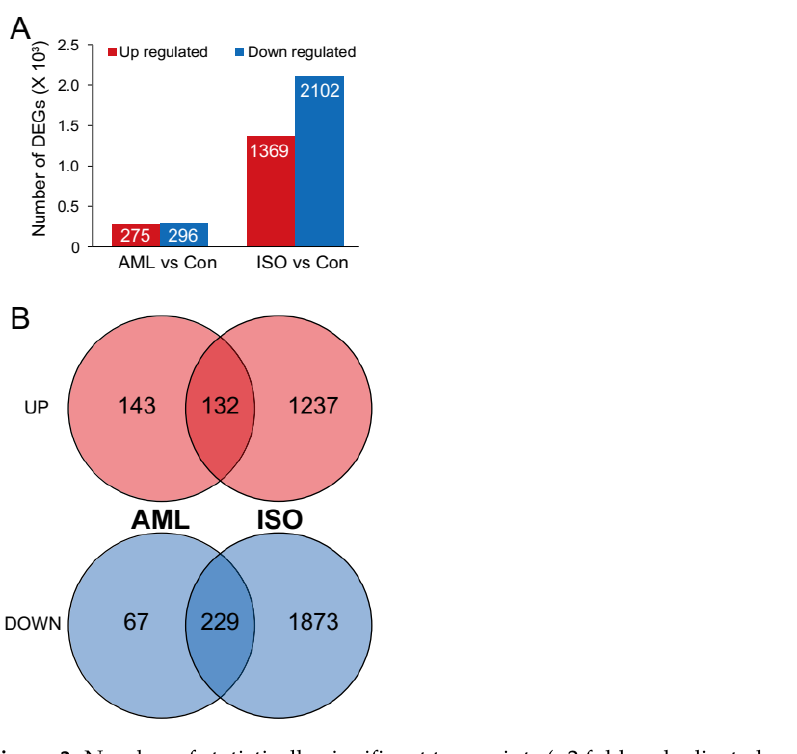
Figure 3. Number of statistically significant transcripts (>2 fold and adjusted- p < 0.05) of genes in AML and ISO exposure groups ( A ) and the number of uniquely or commonly up- or down-regulated transcripts in zebrafish embryos exposed to AML or ISO ( B ).